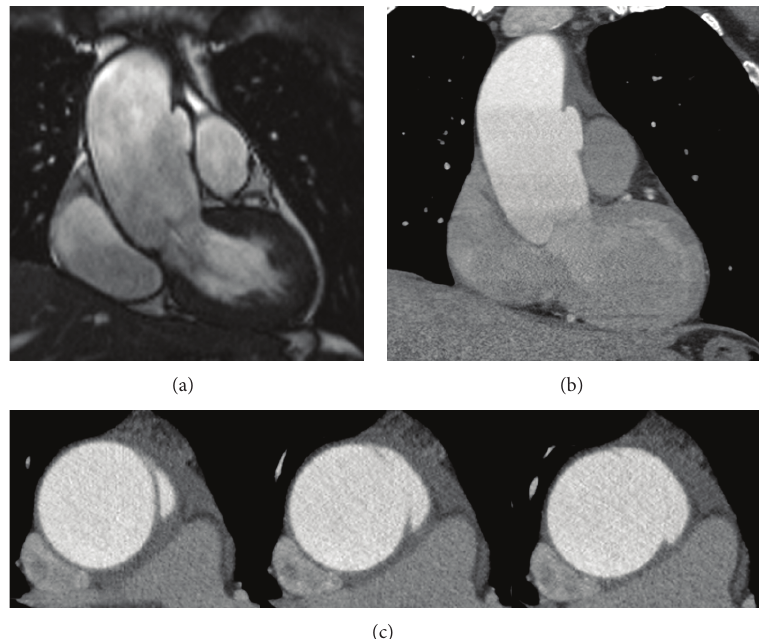
Figure 2: Corresponding double-oblique view of the cine-CMR demonstrating an ulcer-like lesion (acute aortic syndrome, class 4) superior to the aortic root in the even initially suspicious left anterior aortic quadrant (a) and nearly congruent double-oblique (b) and axial (c) reconstructions (spatial resolution 2 × 0.5 × 0.25 mm) as compared to initial CT imaging, this time adequately prospectively ECG-gated. Note the precise demarcation and nearly similar accuracy compared to the preceding CMR of a penetrating aortic ulcer exactly in the same location compared to the initially suspected